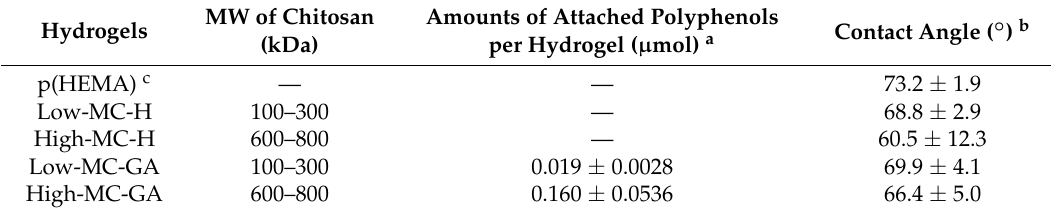
Figure 3. Absorbance spectra of the prepared methacrylamide chitosan-interpenetrating polymer network (IPN) hydrogels functionalized with gallic acid. Table 1. Characteristics of prepared antioxidant hydrogels.